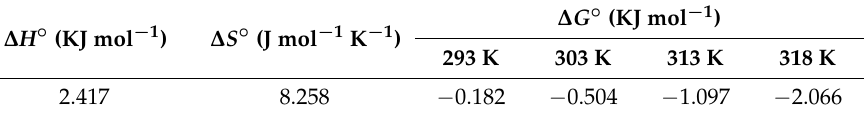
Table 8. Thermodynamic parameters for As(III) uptake by